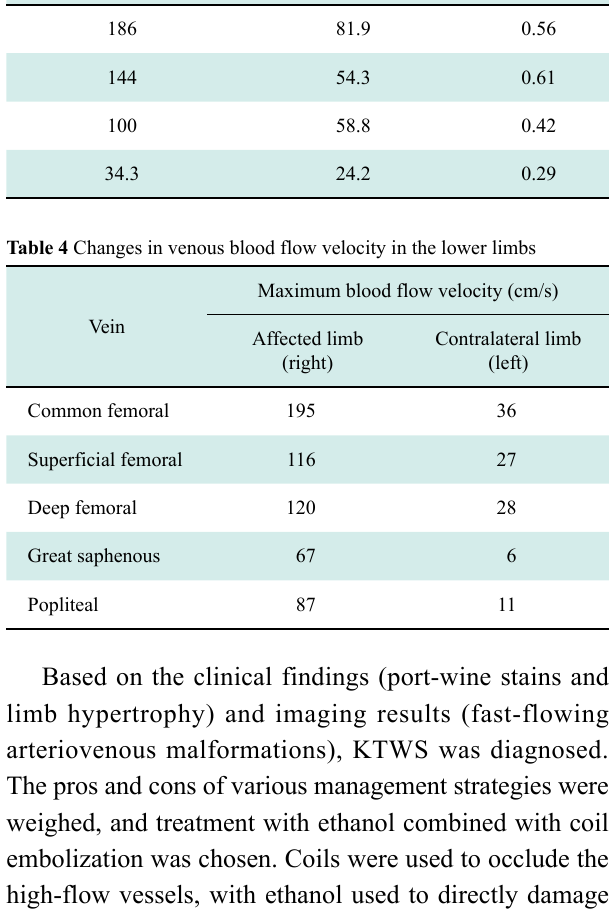
Table 3 Blood flow parameters for vascular malformation (from the inflow to the outflow) Peak systolic velocity (cm/s)